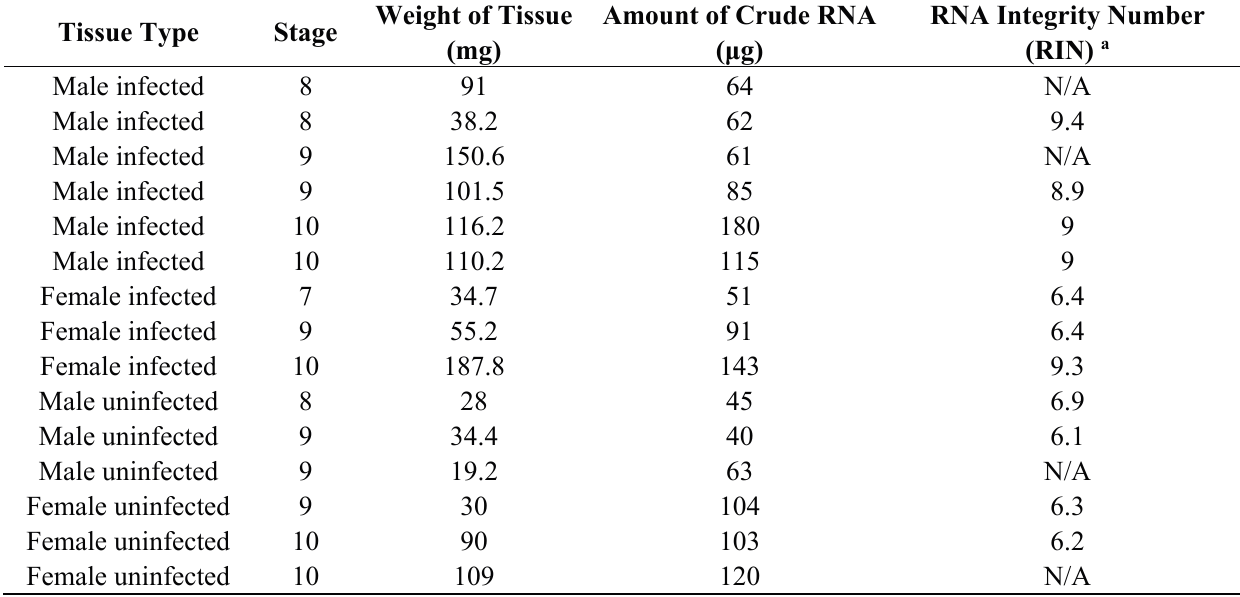
Table 3. Summary of RNA extracted from floral bud tissue based on the stages of interest.